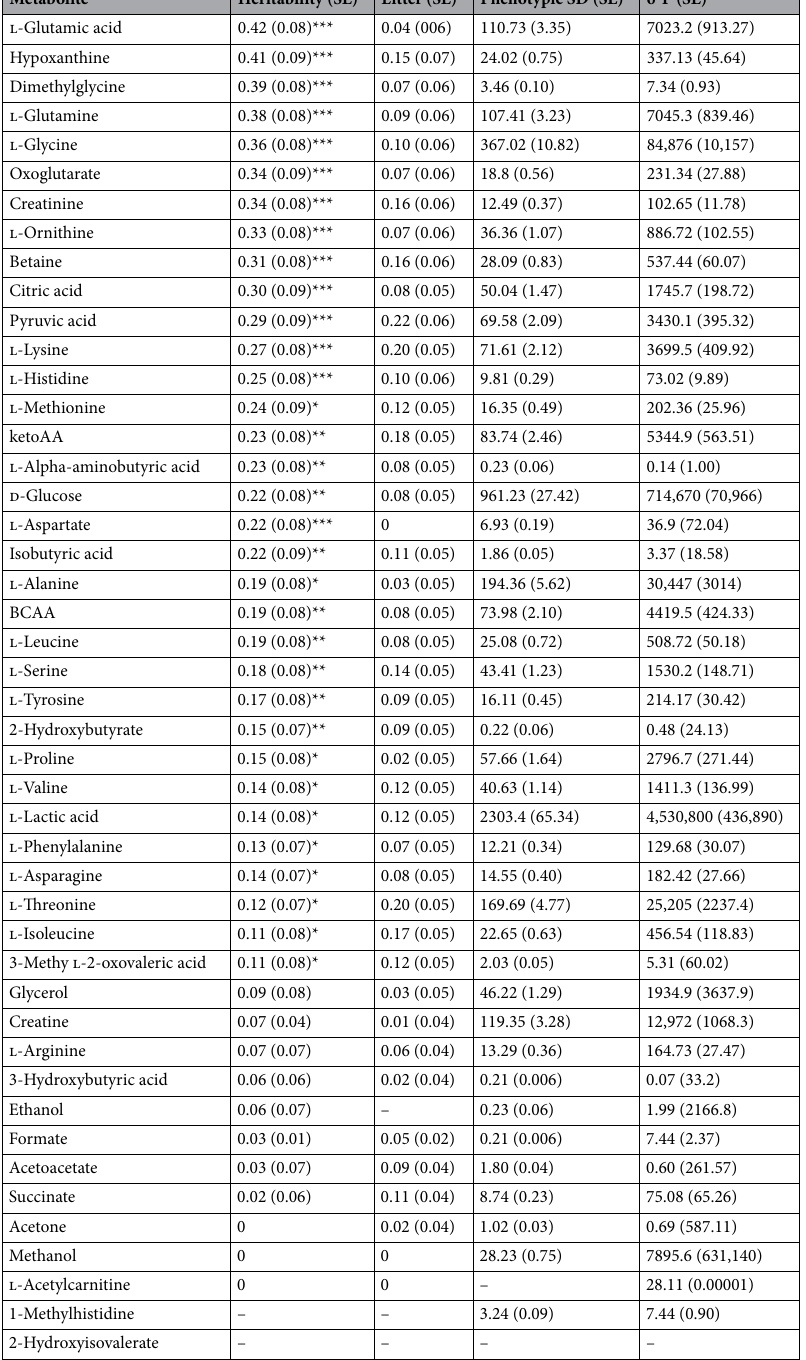
Table 1. Estimates and standard errors (SE) of heritability and litter effects, phenotypic variance SD and variance due to pen (σ 2 P ). Branched-chain amino acids (BCAA) was calculated as the sum of l-leucine, l-isoleucine and l-valine and ketogenic amino acids (ketoAA) was calculated as the sum of l-lysine and l-leucine. Significance of the heritability is indicated as ***, **, *, corresponding to P < 0.001, P < 0.01 and P ≤ 0.05. “–” indicates not